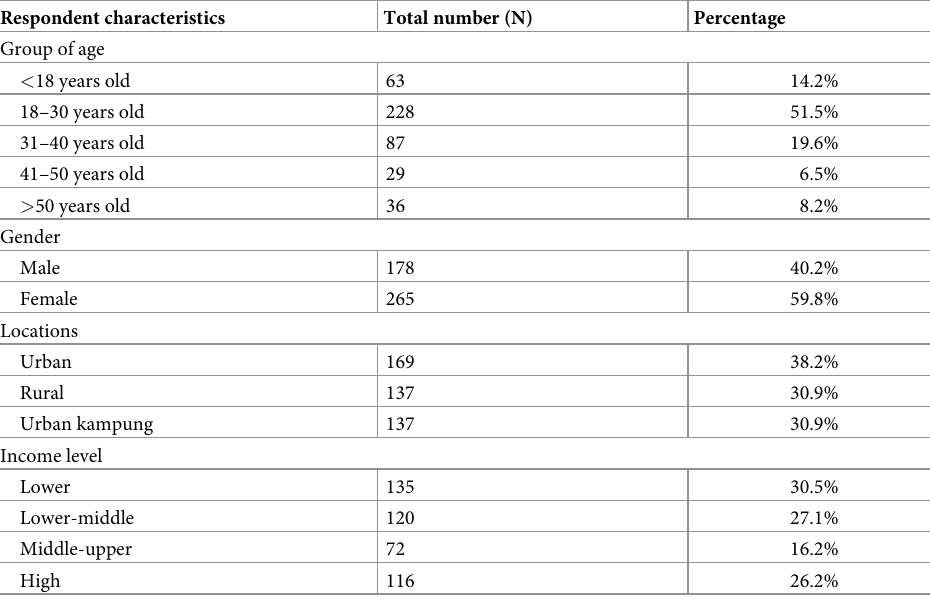
Table 1. Characteristics of the respondents (N =